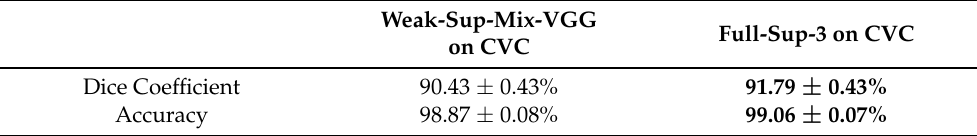
Table 6. Average test-set scores and standard deviation using 10-fold cross-validation on CVC- ClinicDB from the Weak-Sup-Mix-VGG model and from the Full-Sup-3 model as described in text.